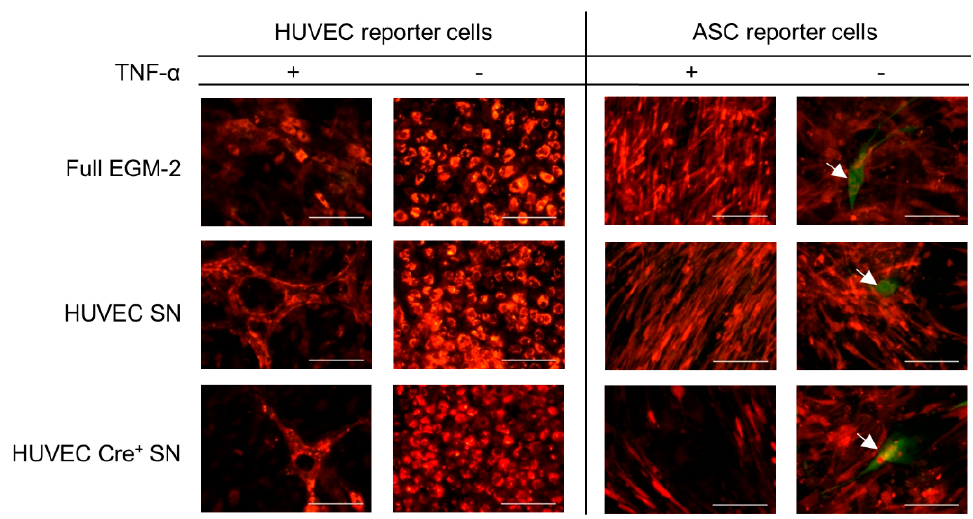
Figure 5. HUVEC and ASC reporter cells cultured under different conditions. Reporter cells were cultured with conditioned medium (supernatant) from HUVEC or HUVEC Cre + . Furthermore, the HUVECs used for conditioned medium production were either stimulated with TNF- α (TNF- α +) or unstimulated (TNF- α -). Reporter cells cultured in full medium with or without TNF- α were used as negative control. Single green cells are indicated by the white arrows. Data was obtained from one experiment conducted in technical triplicates. Scale bar: 100 µm.